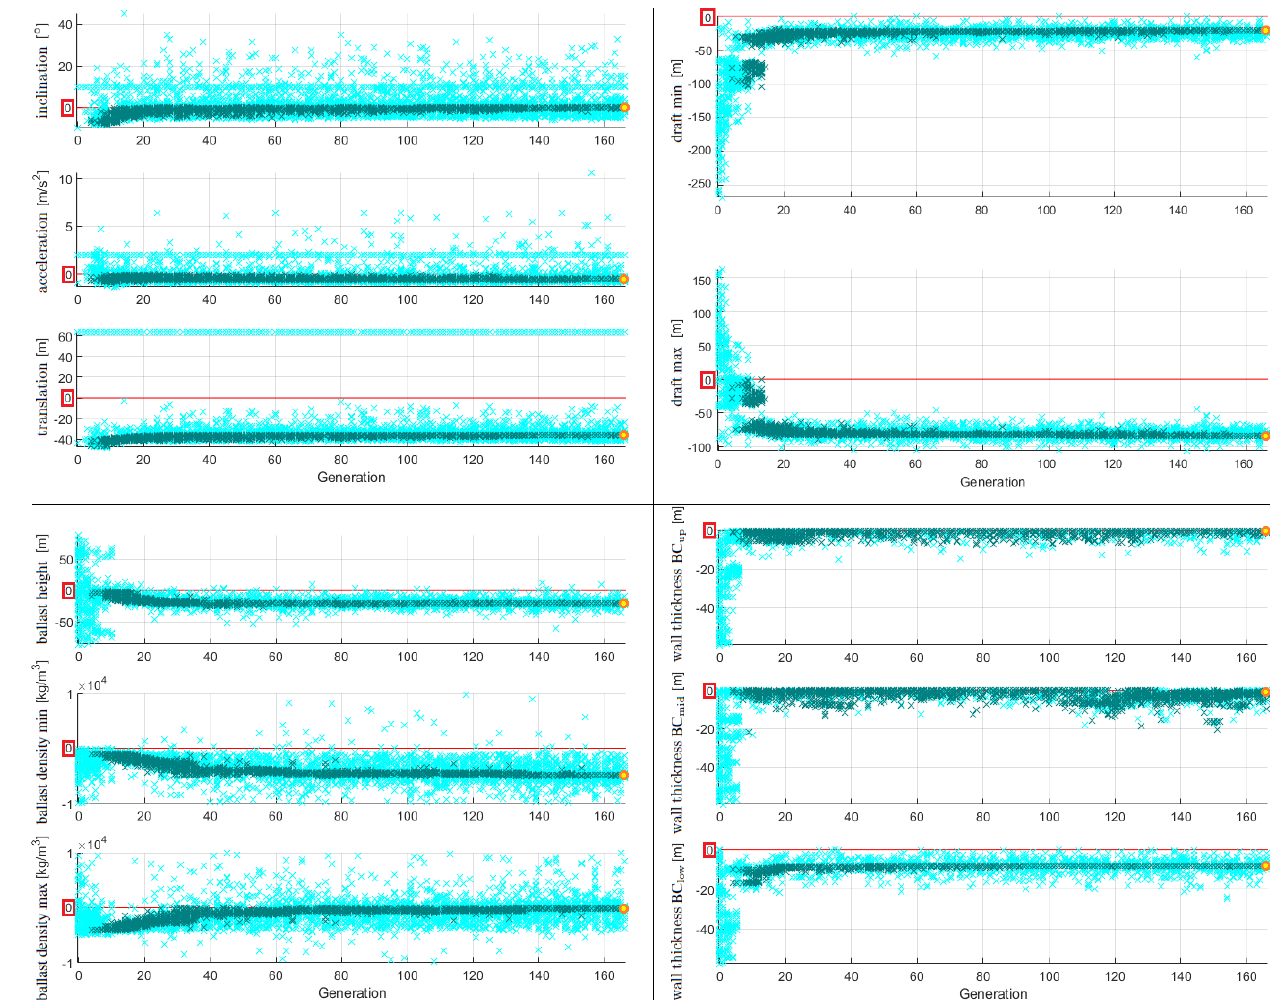
Figure 4. Development of the constraints within the iterative optimization process: all simulated individuals are represented by light cyan crosses and those complying with all constraints by dark bluish green crosses, the best-performing individual is marked with a yellow filled circle framed in orange, and the maximum allowable value is plotted as a red